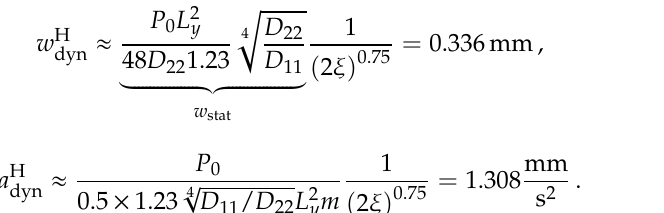
Figure 13. ( a ) FE model of the analyzed slab and ( b ) first eigen shape of the slab f 0 =1.97 Hz.